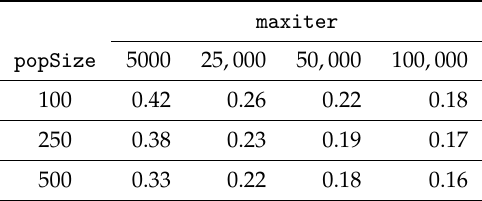
Table 8. Relative error between the exact (Section 3.2) and the approximated solution using GAin terms of the maximum number of iterations and the population